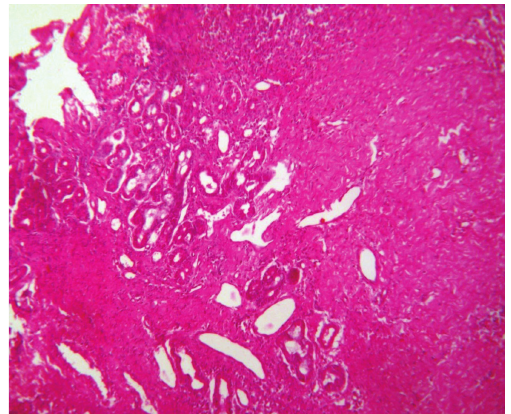
Figure 5: Photomicrograph of biopsy (10x) H&E oral epithelium with large actinomycotic colonies ( f ).